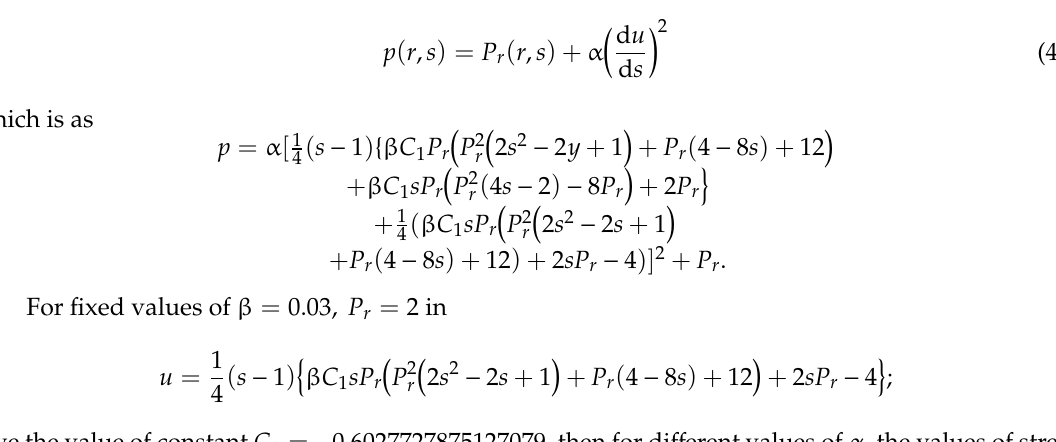
The Equation (6) for the stress, after some manipulation becomes in dimensionless form as